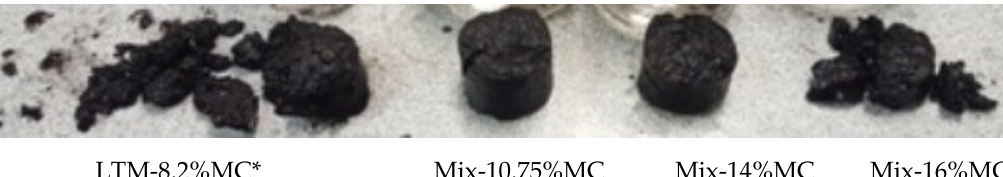
Figure 12. Water immersion results. *MC: Moisture content.